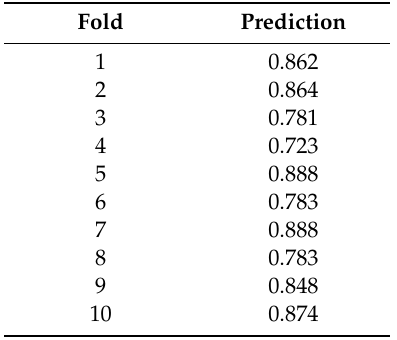
Table 3. Area under Curve (AUC) evaluation of ensemble with k-NN base classifier .